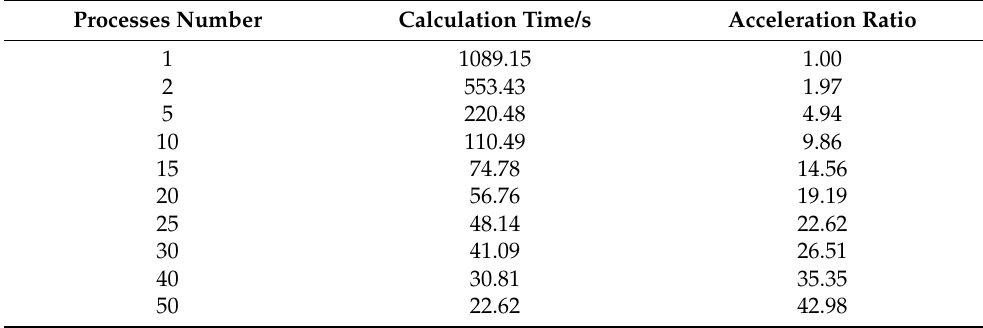
Table 1. Calculation efficiency